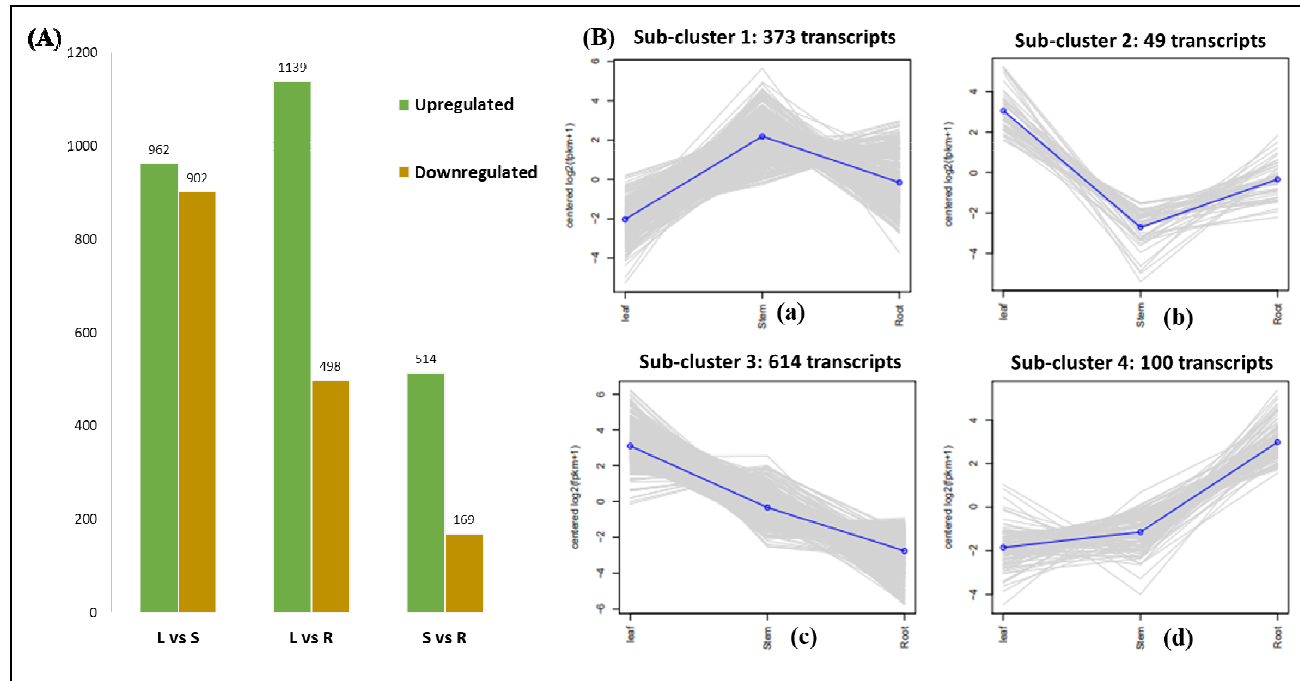
Figure 2. ( A ) Histogram representing significant DEGs in three combinations: leaf vs. stem (L vs. S), leaf vs. root (L vs. R), and stem vs. root (S vs. R). ( B ) Clustering of 1136 significant transcripts in leaf, stem, and root: ( a ) Subcluster 1 represents higher expressions of transcripts in the stem; ( b ) Subcluster 2 in the leaf; ( c ) Subcluster 3 in the leaf; ( d ) Subcluster 4 in the root. The color line in subfigure B represents the median